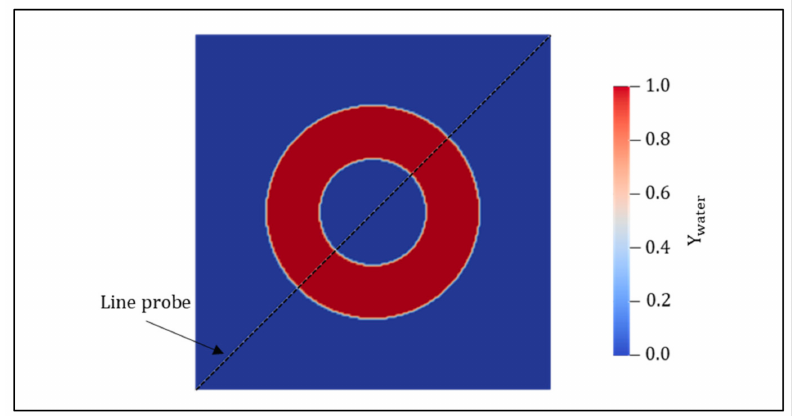
Figure 2. Species distribution at the initial time and probe emplacement. For better understanding of the test case, 5 spatial distributions of Y water along the line √ probe are presented in Figure 3 with a dimensionless distance X = x/ 2m. The finest mesh and the smaller time step were used in this figure. Computations with the other meshes are used to demonstrate the grid convergence. The distribution keeps its symmetry. The integral encompassed by one curve and the x axis decreases over time. At the final time ( 50 s ) , the field’s gradient ∂ Y water / ∂ X is attenuated, meaning the mixture is more homoge- neous. A maximum value less that 0.1 is present at the center of the computational domain.